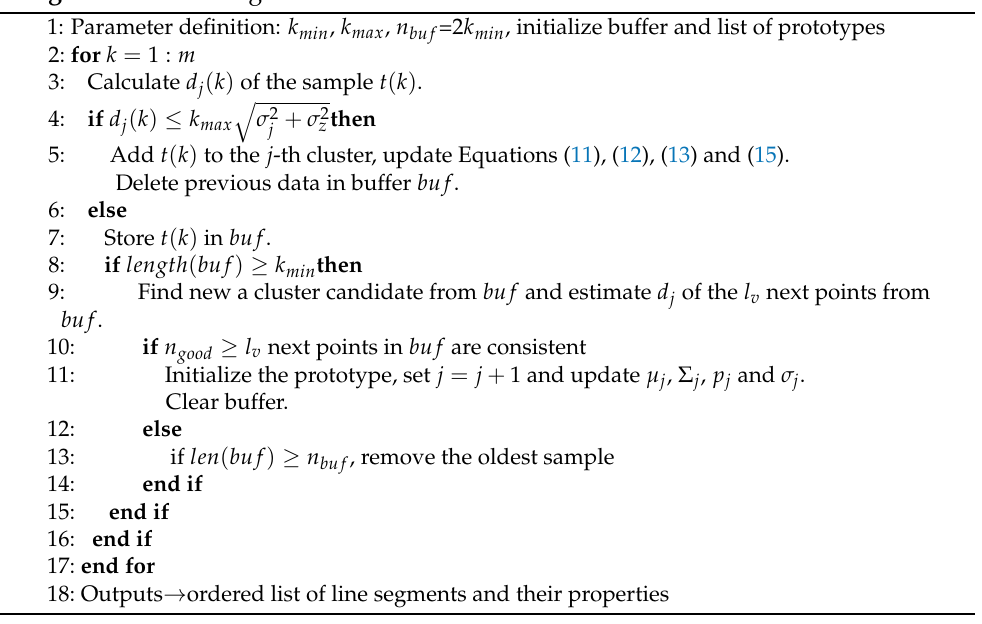
Algorithm 1: Line segment detection with the EPCC method.